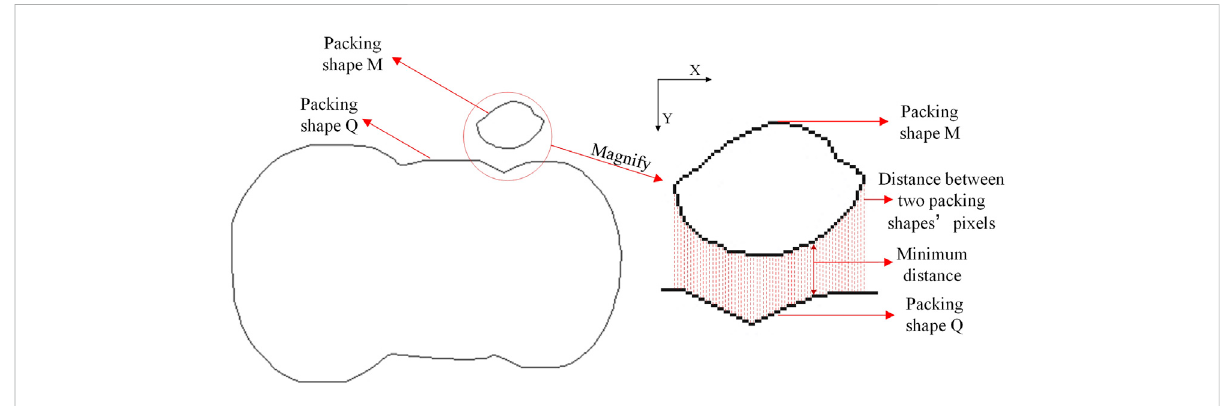
FIGURE 12 Make a collision using judgment of